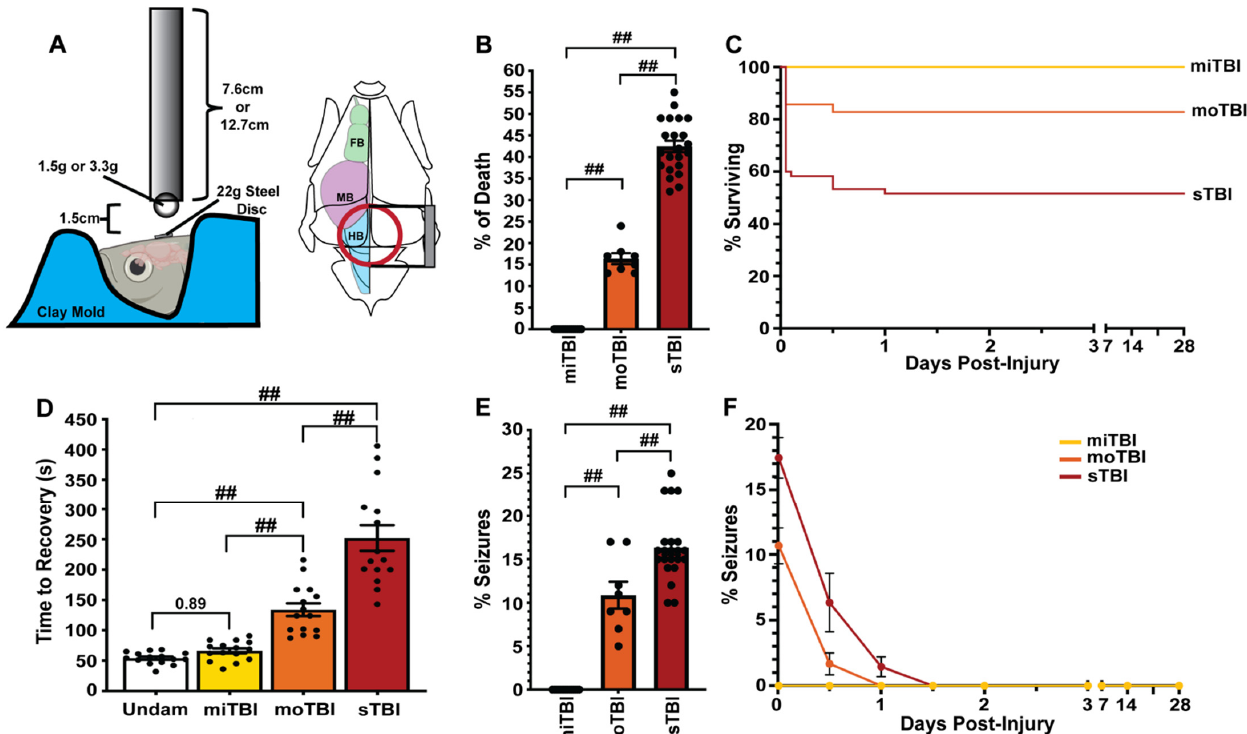
Figure 1. A reproducible and scalable blunt-force TBI in adult zebrafish. ( A ) Diagram depicting the conditions of the modified Marmarou weight drop scaled to the adult zebrafish. On the left, the tube through which the dropping ball falls is shown relative to the head and brain of the zebrafish. On the right, a red circle over the brain diagram shows the relative impact center of the dropping ball (forebrain in green, midbrain in purple, and hindbrain in blue). ( B ) Following damage, the percentage of fish dying significantly increased relative to the damage severity (n ≥ 200 fish). ( C ) Graph of the percentage of fish surviving following TBI out to 28 dpi. All mortality took place within 1 dpi (n = 30). ( D ) The recovery time for the fish to right themselves without exhibiting akinesia, ataxia, and motor incoordination significantly increased with damage severity (n = 15). ( E ) The percentage of fish that experienced intense tonic-clonic seizures significantly increased relative to the damage severity (n ≥ 200 fish). ( F ) The percentage of fish exhibiting post-traumatic seizures observed out to 28 dpi significantly increased relative to the damage severity. No seizures were observed after 1.5 dpi for any of the damage severities (n = 30). Forebrain, FB, hind-brain, HB, midbrain, MB All graph data points are Mean ± SEM. Statistical